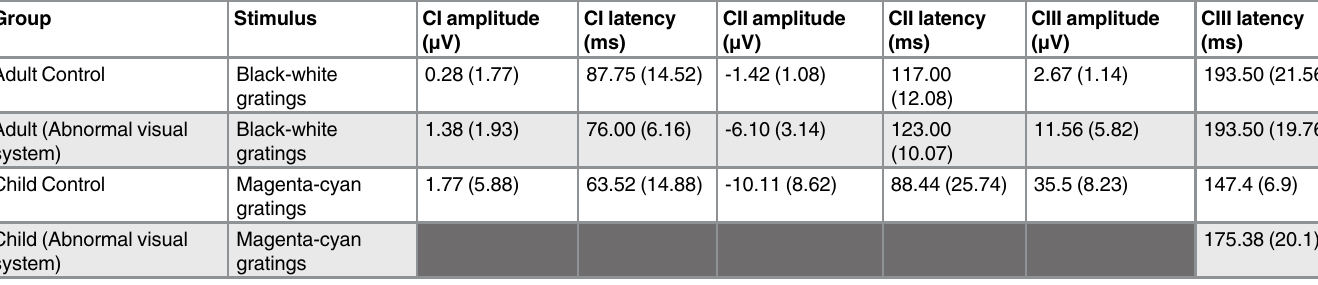
The cells in grey indicate abnormal visual system data. Where components were not repeatable in latency for a group, mean (SD) are not reported for that group and the cells are shaded dark